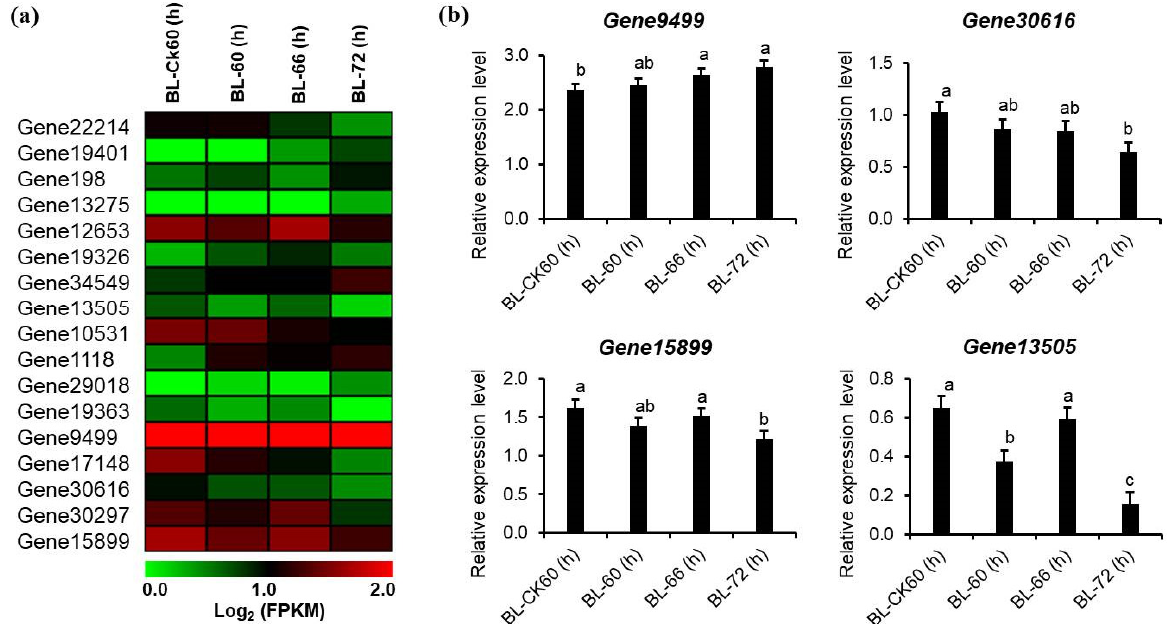
Figure 7. Expression profiling of starch and sucrose metabolism DEGs in the hypocotyl of R. pseudoacacia -148 during adventitious root formation; ( a ) Heat map illustration of log2 (FPKM) values for annotated genes during starch and sucrose metabolism pathway; ( b ) Relative expression of starch and sucrose metabolism pathway genes as determined by RT-qPCR. The data presented are the average of three technical replicates. Different letters indicate significant difference by least significant difference (LSD) test ( p ≤ 0.05). Bar = SD.